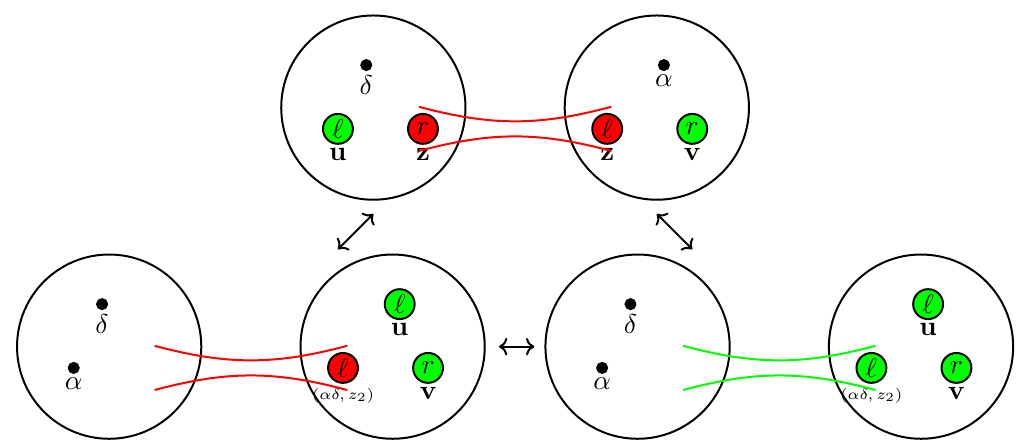
Figure 10. Three ‘S-dual’ frames of the basic A 1 four punctured sphere in Class S 2 . On the top is the canonical weakly coupled frame with fluxes for U(1) On the bottom left is the S-dual frame obtained by gluing a quiver tail to the T F B = ( − 1 , 1 , 1) . On the bottom right is the S-dual frame obtained by gluing a quiver tail to the T A 4 4 theory with fluxes F = ( 1 , 1 , 1) . Green (red) circles indicate maximal punctures of colour c = 0 A 4 4 ( c = 1 ). o = l, r indicates the orientation of a maximal puncture. Dots indicate minimal punctures.